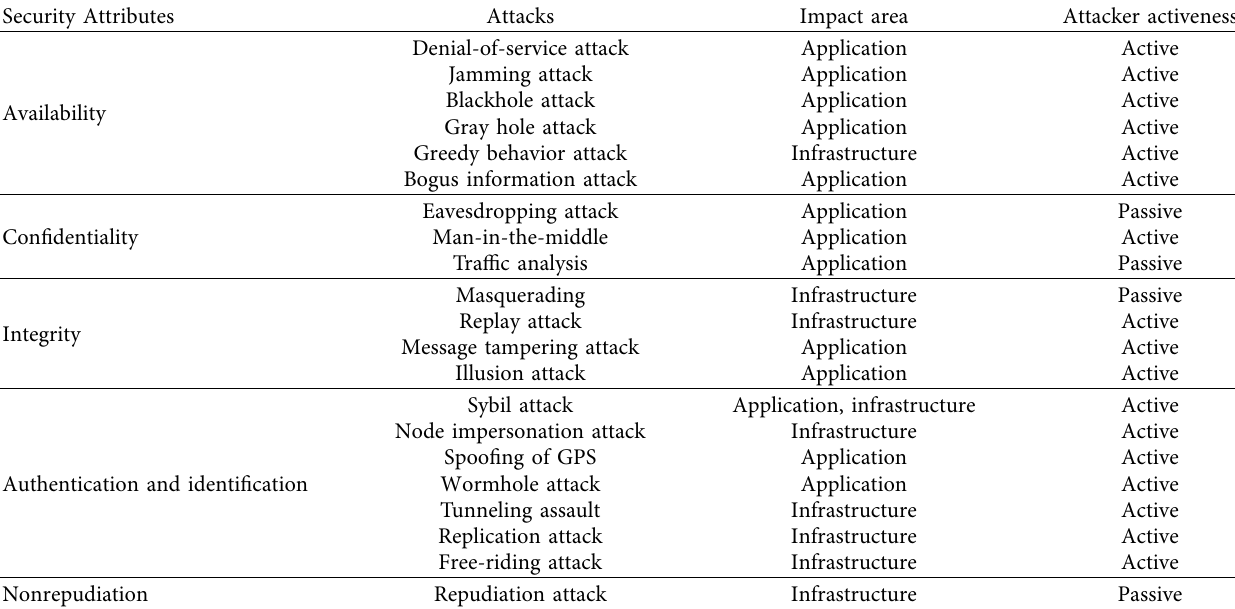
Table 1: Category of various attacks in